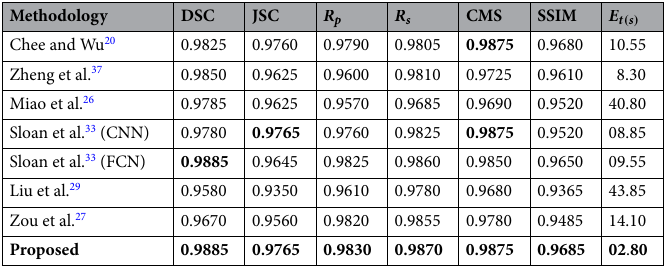
Table 1. MRI and CT images registration performance. Best result for each metric is shown in bold.